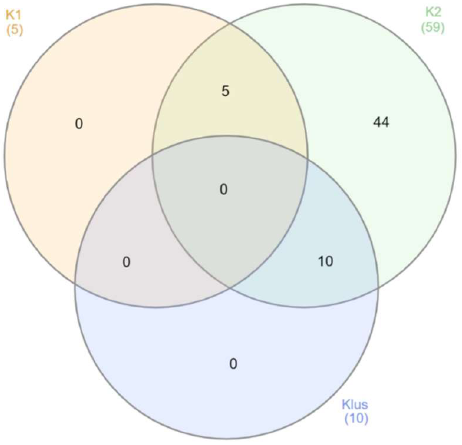
Figure 2. Number of strains resistant to K1, K2 and Klus killer toxins (Venn diagram). A total of 59 of the 62 non-killer yeast were resistant to the K2 toxin. No resistant strains to toxin K28 were found.